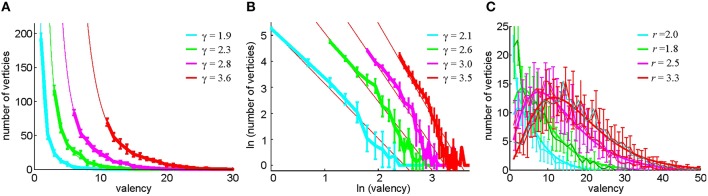
Statistics of the vertex degrees in relational graphs. (A) The histogram of the vertex degrees k in the neighbor-controlled relational graph G(n0), computed for n0 = 2, 4, 7, 12 (Method II) and fitted to a power law distribution P(k) ~ k−γ. The graph demonstrates that G(n0) is a scale-free network. (B) The same distribution on the log-log scale and an independent linear fit of the powers γ. The confidence intervals of the two fits, ranging between ±0.15 and ±0.3, overlap for each case. (C) In the pairwise coactivity threshold (Method I), the histogram of the relational graph's vertex degrees is fit by negative binomial distribution, suggesting that G(θ) is similar to a random network.